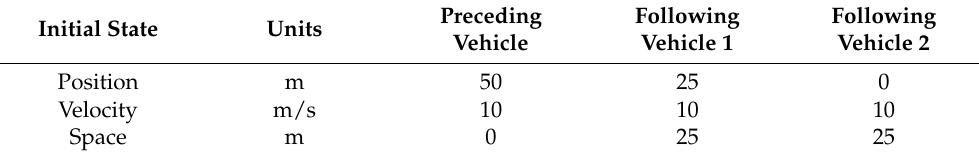
Table 5. Initial states of ICVs.